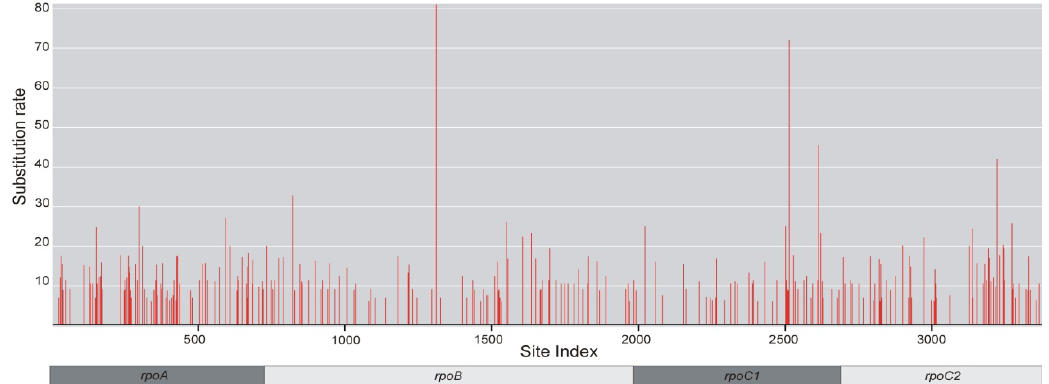
Figure 2. Distribution of substitution rates across rpo genes as calculated in HyPhy using the GTR model of evolution. The relative position of sites in analyzed gene fragments is indicated by a bar given below the